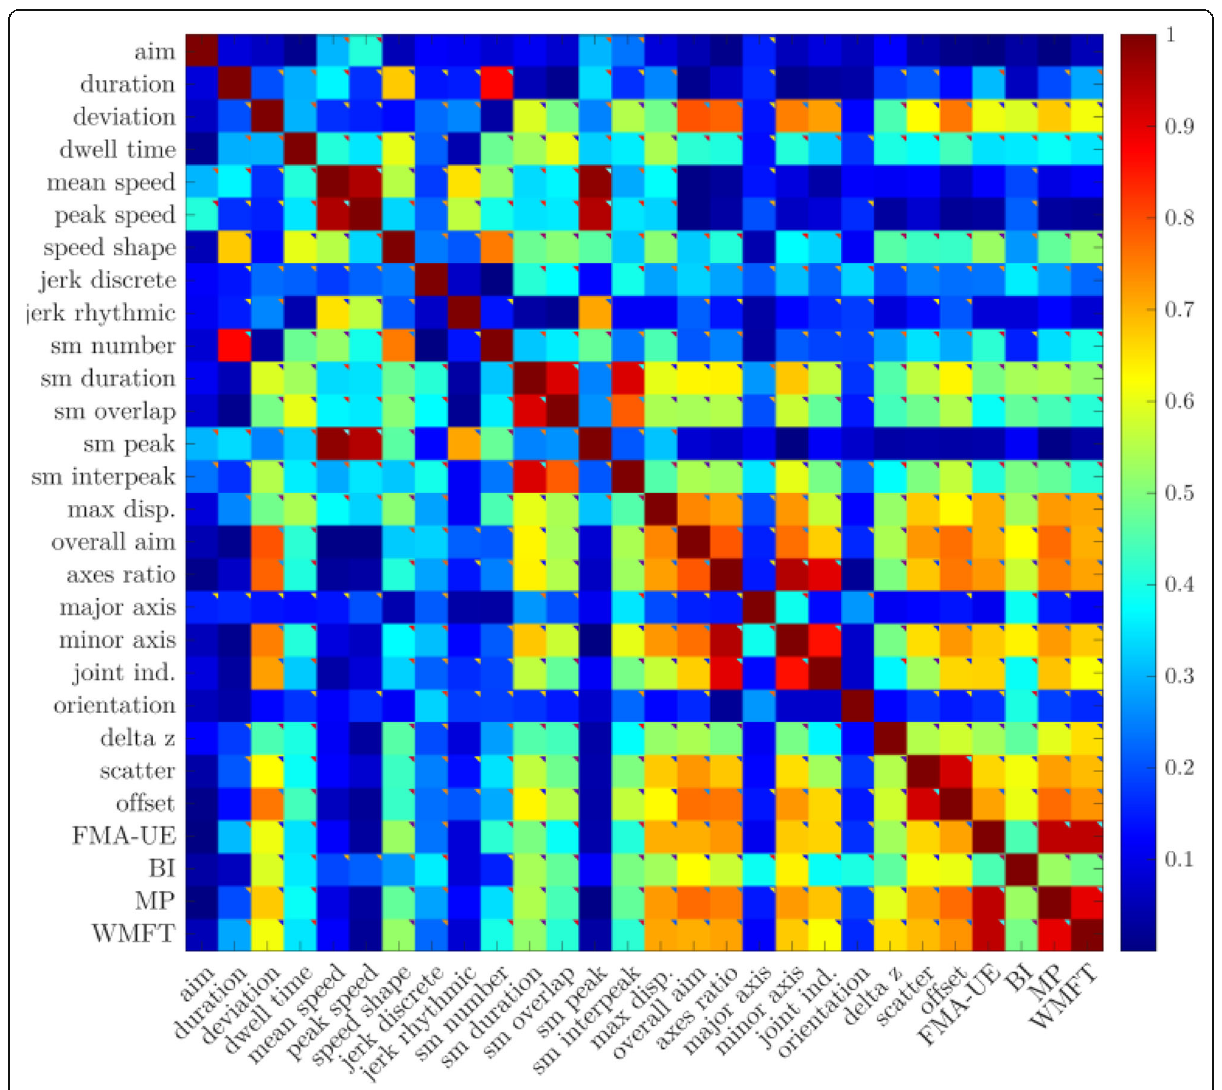
Fig. 1 Heatmap of S/E kinematic and kinetic data correlation with clinical